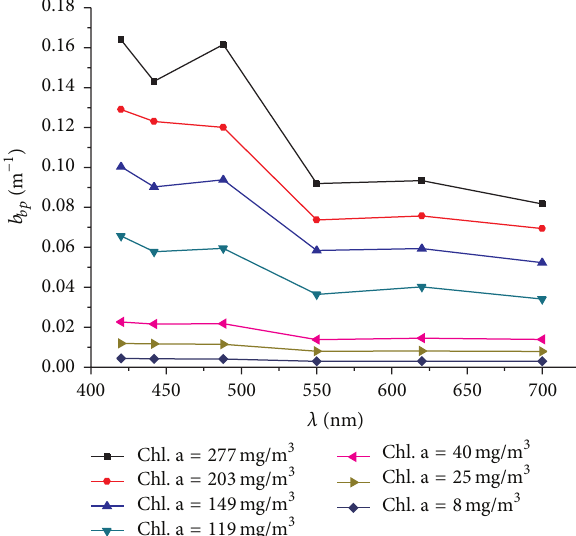
Figure 3: Spectral values of backscattering coefficients of A. anophagefferens . (Solid points are averaged